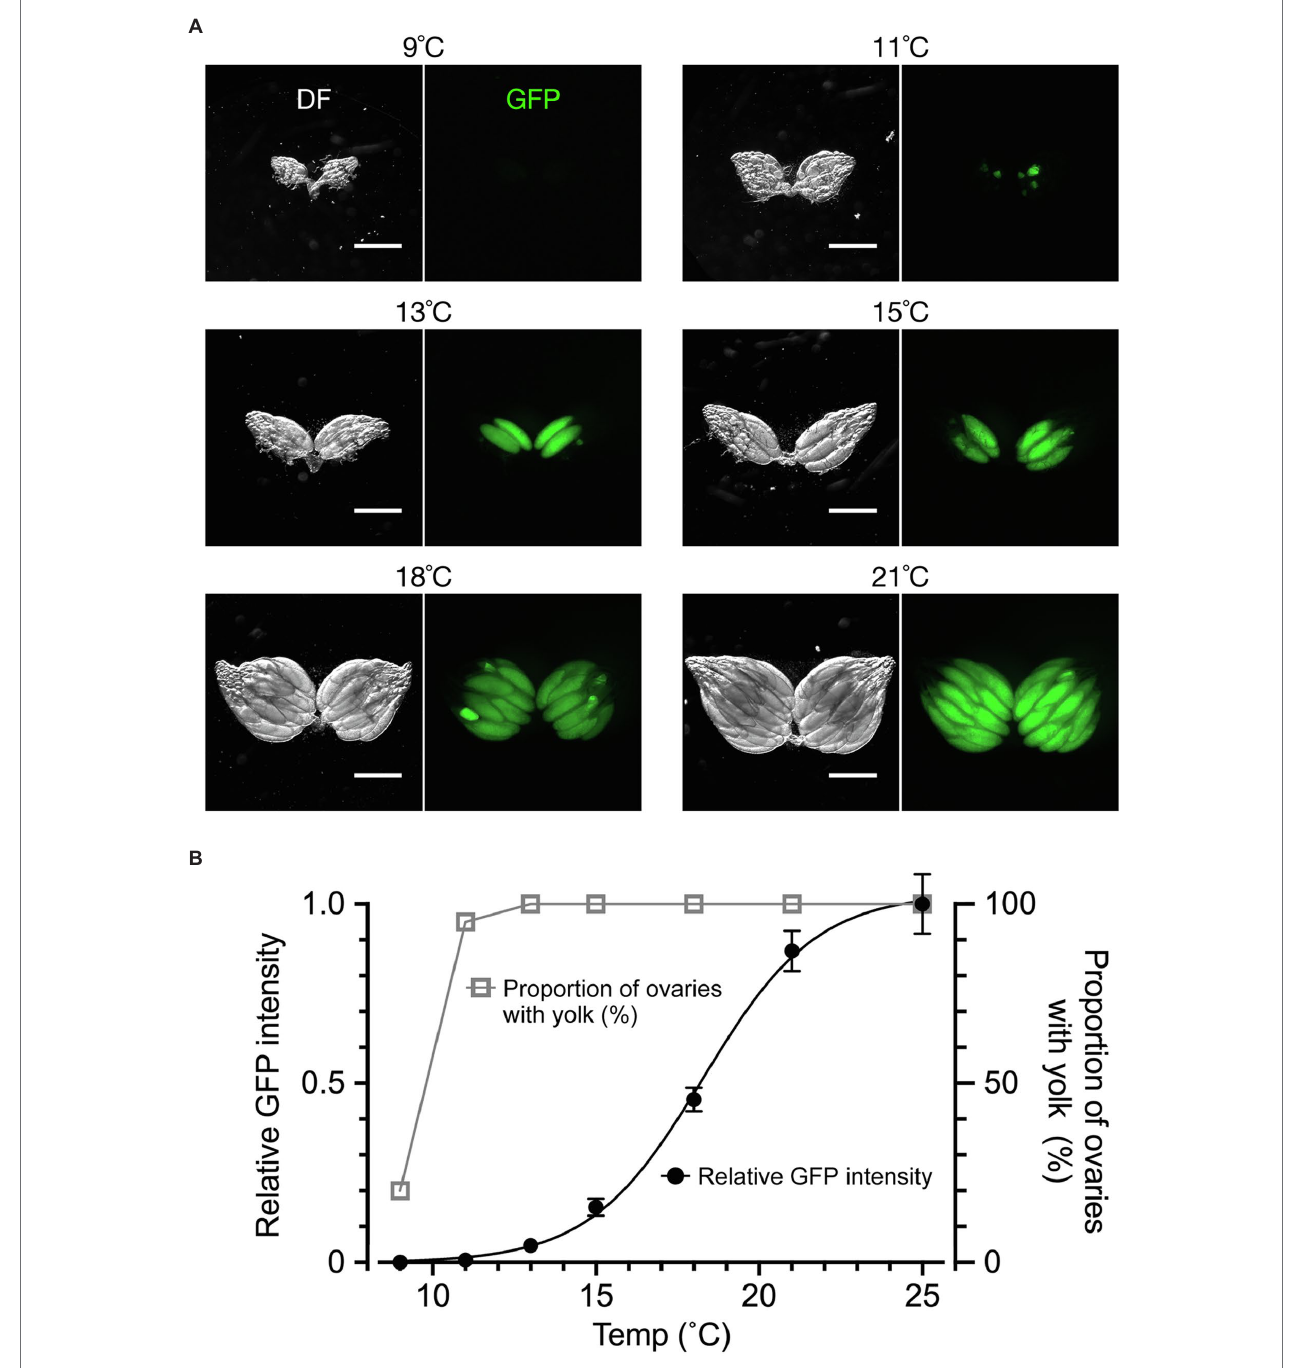
FIGURE 3 | The temperature dependence of yolk accumulation. (A) Representative images of ovaries (DF: dark field; GFP: fluorescence) from flies kept for 7 days in vials with normal food at the indicated temperature after emergence. Scale bar: 500 μ m. (B) Temperature–yolk accumulation relationships. The ordinate scale on the right: the proportion of ovaries with yolk-containing egg chambers (open triangles and grey line) representing the non-dormancy rate according to the conventional method. The ordinate scale on the left: the mean and SEM for fluorescence intensity values (in a. u.; filled circles and black line). n = 20. The line represents a four parameter logistic curve in which the maximum value is 1.030, the minimum value is − 0.001, IC 50 is 18.28 and the slope factor is 0.2504. The animals were fed on a normal cornmeal–yeast diet (see Methods for compositions) throughout all stages. They were kept at 25 ° C during the larval stage and then kept at the indicated temperature after emergence. The photoperiod applied was L/D: 12/12 throughout the experiment. The genotype of flies: Yp1::GFP/+